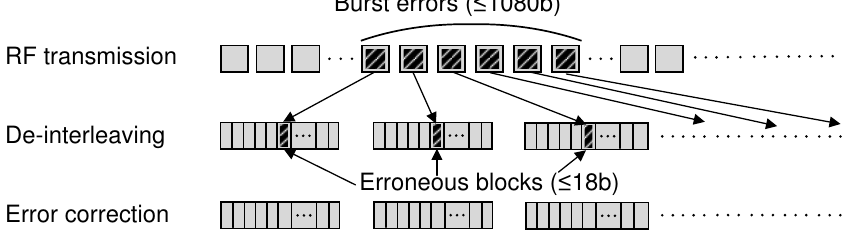
Figure 6. The example of the burst error correcting with proposed interleaving scheme.